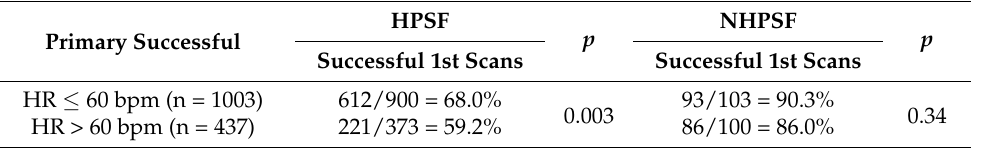
Table 2. Subgroup analysis for primary successful (i.e., at least diagnostic image quality of all coronary segments) scans as a function of selected clinical and demographical parameters. The rate of primary successful scans with HPSF was significantly lower than with NHPSF in all subgroups ( p < 0.05). HPSF: high-pitch spiral scan first; NHPSF: non high-pitch spiral scan first; HR: heart rate; SR: sinus rhythm without extrasystoles; ES: extrasystoles; BMI: body mass index; bpm: beats per